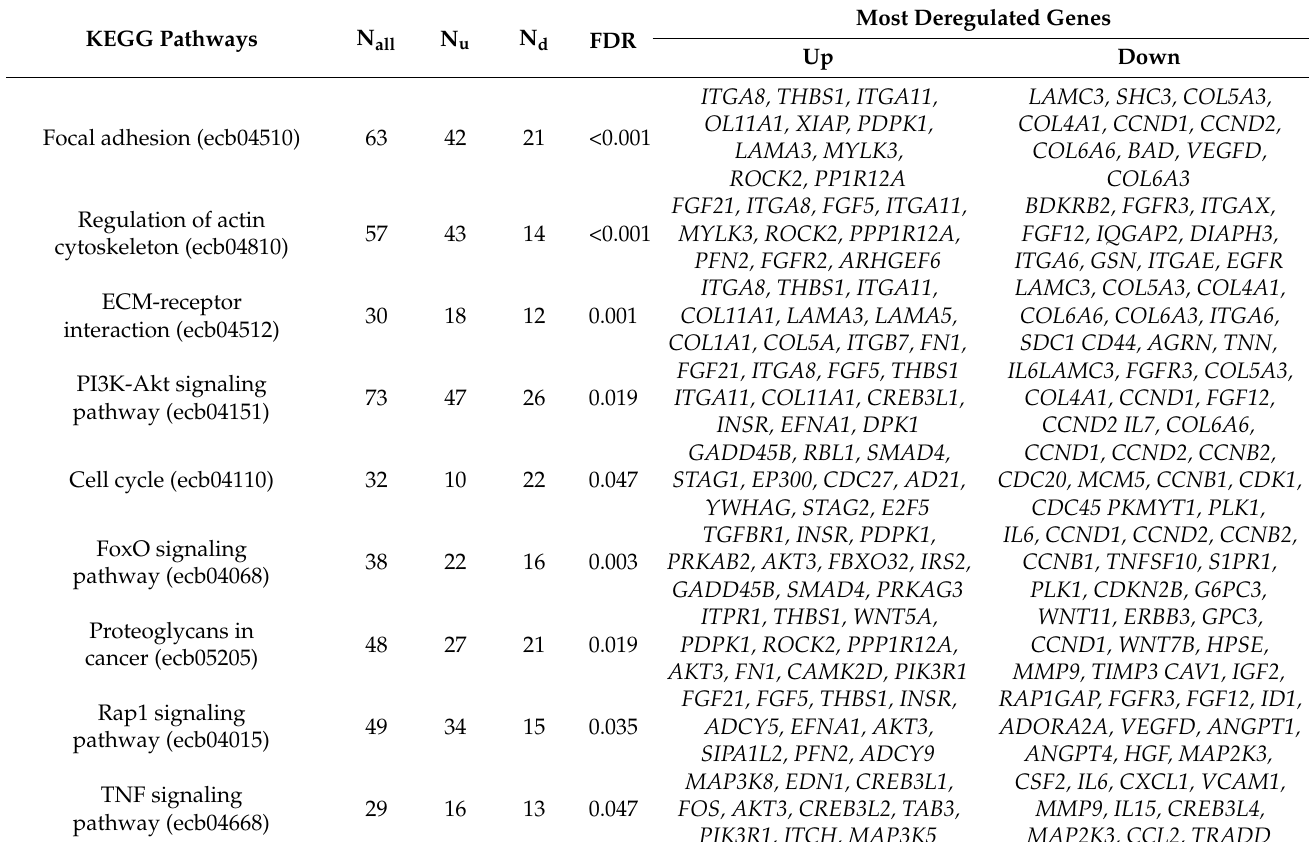
Table 4. The significant enrichment in molecular KEGG pathways detected on the basis of compara- tive analysis of DEGs set between BPV-E1ˆE4 and control